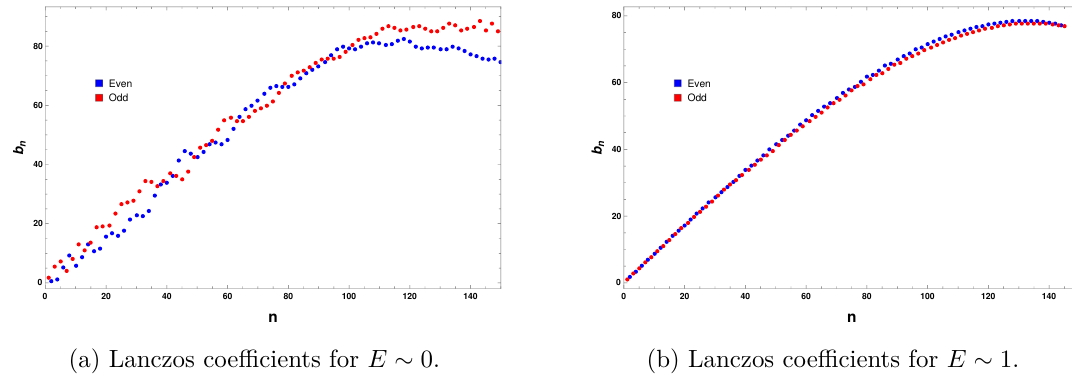
Figure 6. Growth of Lanczos coefficients and microcanonical K-complexities for different energies. (a) shows the behavior away from the saddle where the odd and even b At small n one can observe that the growth is roughly linear, which is indicative of an exponentially increasing K-complexity. Therefore, the microcanonical K-complexity is also sensitive to the presence of the unstable saddle point, even away from the saddle itself. (b) shows the growth of b saddle. The odd and even coefficients are almost